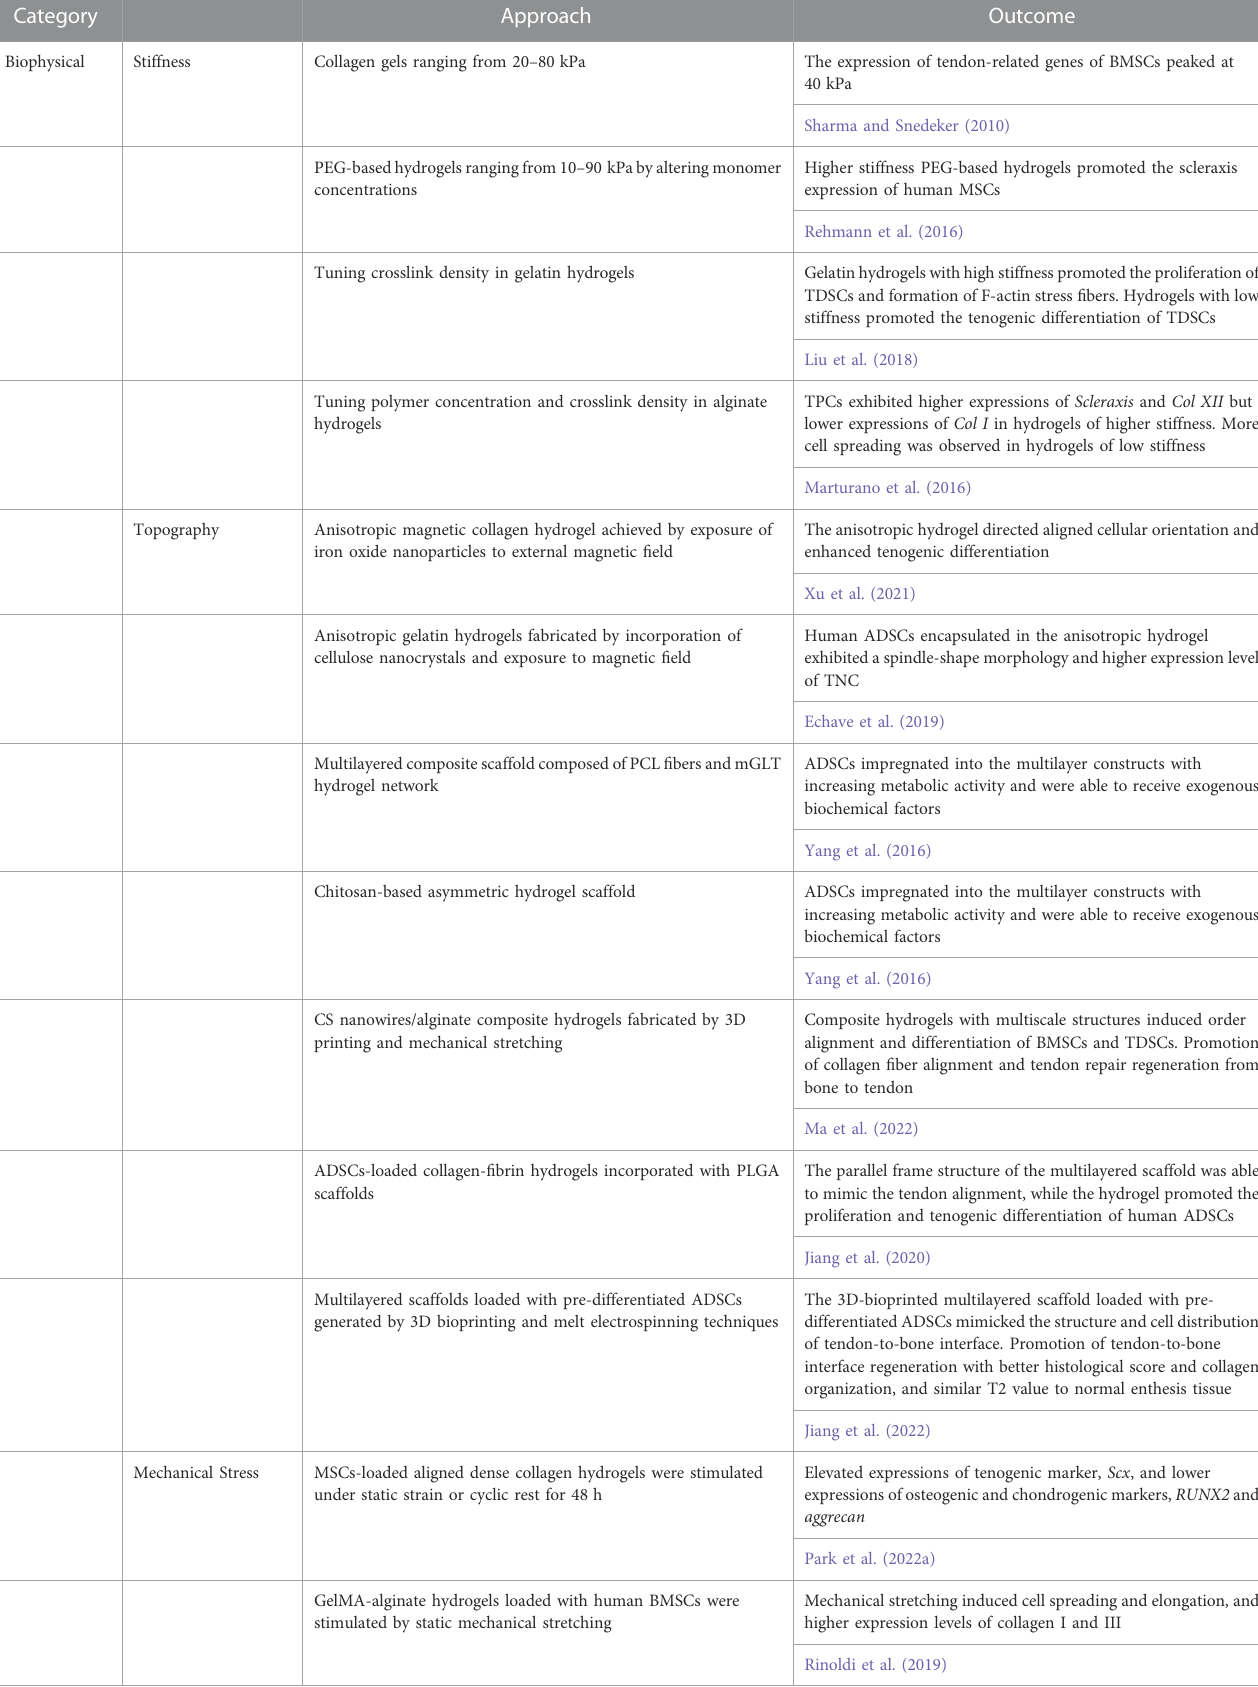
TABLE 2 Tuning biophysical and biochemical factors of hydrogels for stem